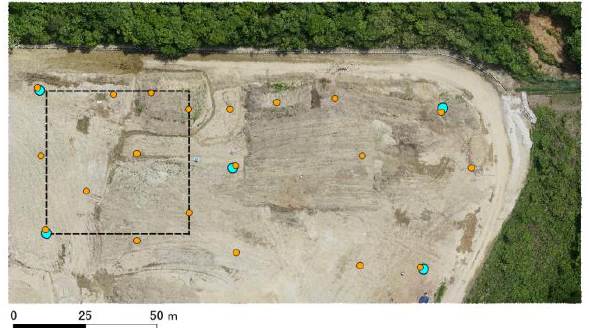
Figure 1. Skymatix LS-1 UAV